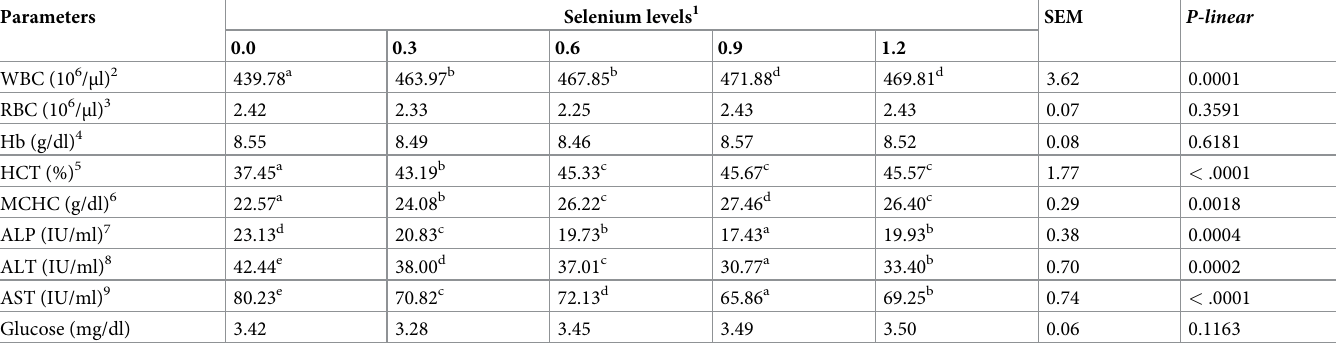
Table 6. Blood biochemical properties of juvenile silver carp fed on different levels of selenium methionine.